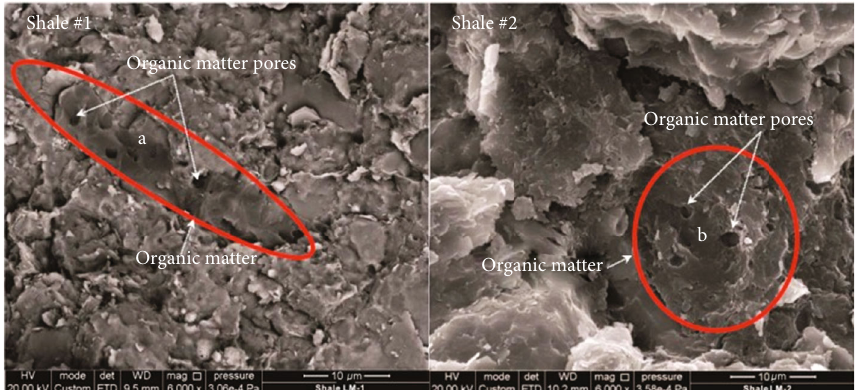
Figure 4: SEM image of shale matrix nanopores [55].